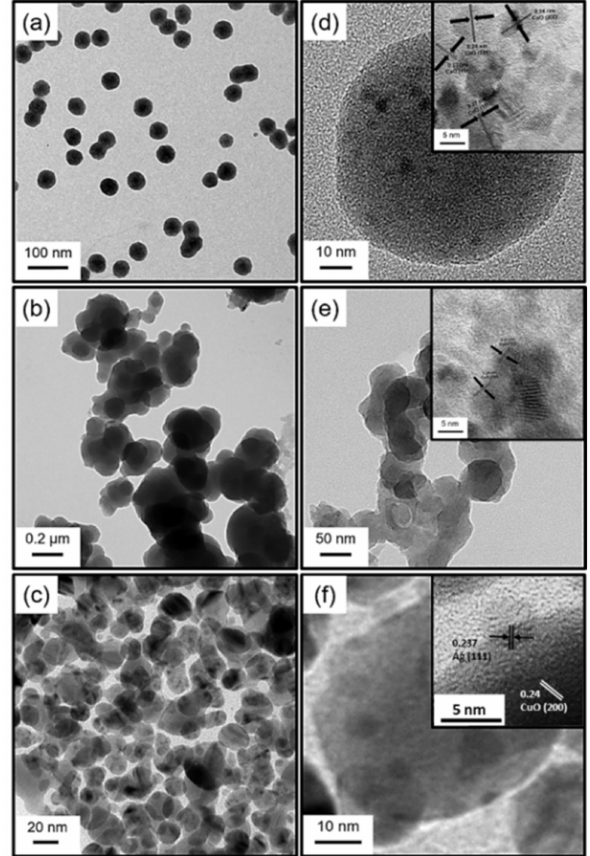
Figure 1. TEM images of various nanoparticles: ( a , d ) CaO NPs at different magnifications; ( b , e ) PDA/CaO nanocomposites at different magnifications; the insets in ( d ) and ( e ) are HRTEM im- ages of random CaO nanoparticles and PDA/CaO nanocomposites, showing lattice spacing between CaO (111) and (200) planes. ( c , f ) Ag/PDA/CaO nanocomposites at different magnifications; the inset in ( f ) is an HRTEM image of a random Ag/PDA/CaO nanocomposite showing lattice spacing between Ag (111) and CaO (200) planes as